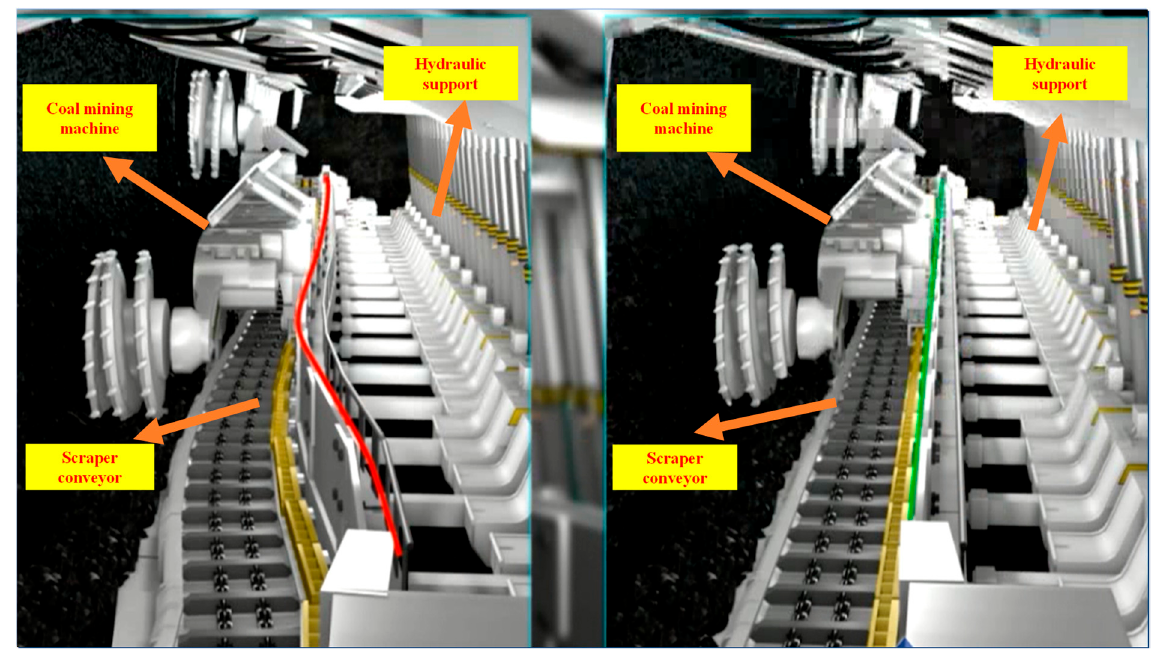
Figure 4. Schematic diagram of hydraulic support and machine automation.